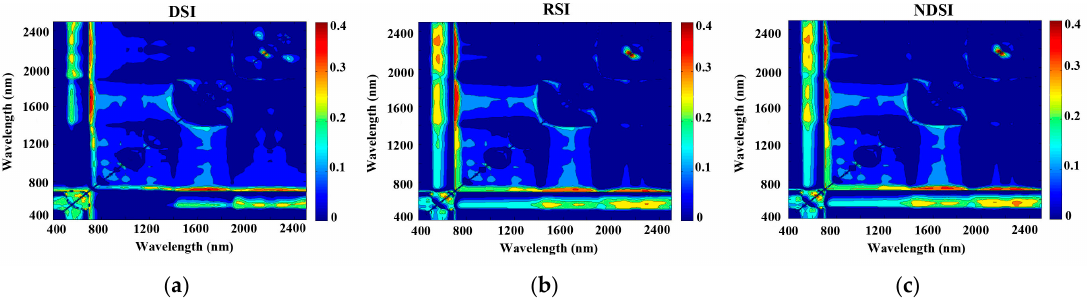
Figure 5. Contour maps of coefficients of determination for the linear relationship between three vegetation indices (DSI ( a ); RSI ( b ); or NDSI ( c )) and the chemically-measured leaf N concentration using the spectra measured by the white background. Table 3. Linear regression between three vegetation indices and chemically measured leaf nitrogen